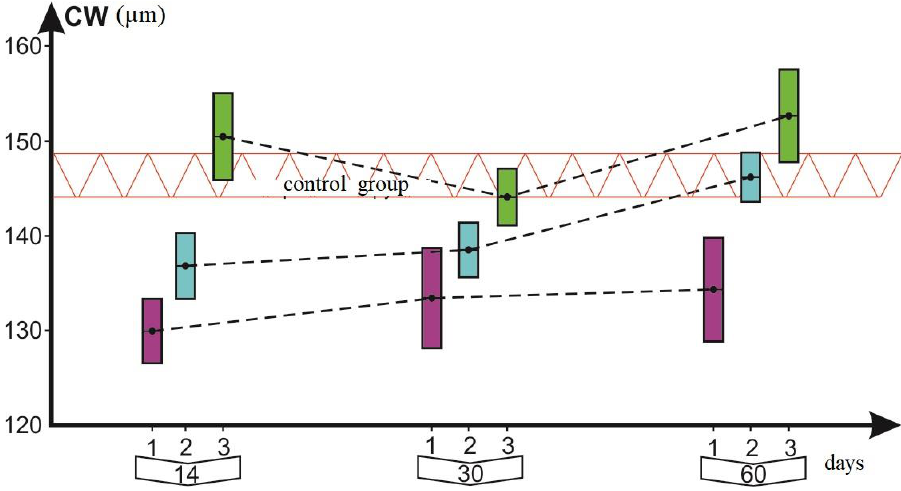
Figure 5. Dynamics of the thickness of the cortical layer for the studied groups of animals.